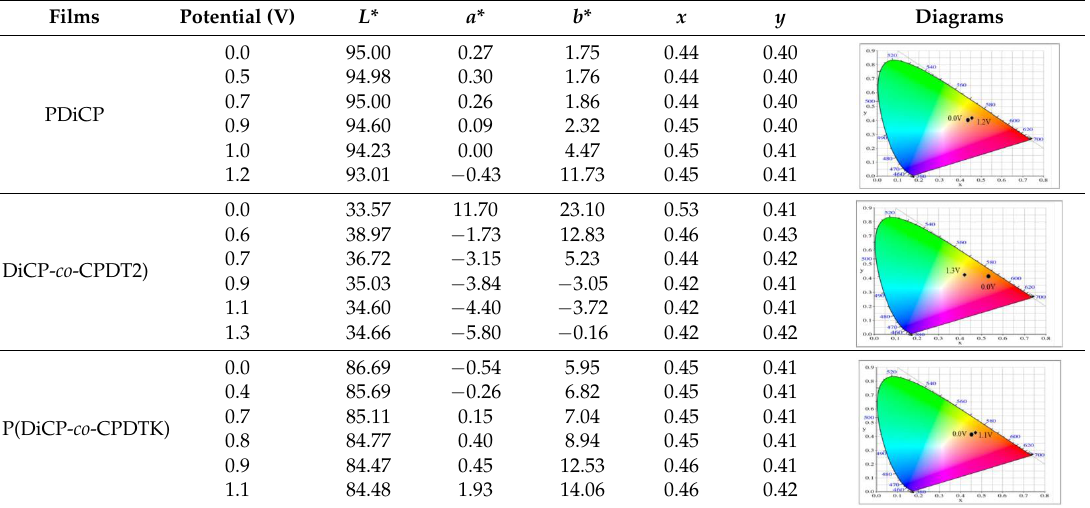
Figure 5. UV – VIS spectra of ( a ) PDiCP; ( b ) P(DiCP- co -CPDT); ( c ) P(DiCP- co -CPDT2); ( d ) P(DiCP- co -CPDTK); and ( e ) P(DiCP- co -CPDTK2) electrodes on ITO in 0.2 M LiClO 4 containing ACN/DCM (1:1, by volume) solution.